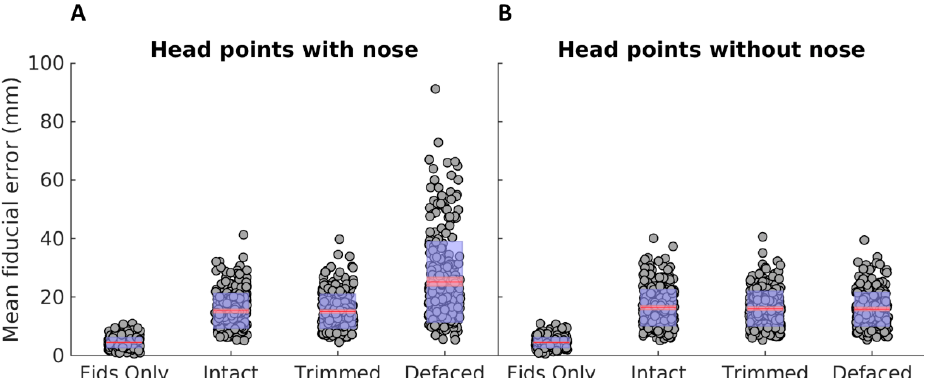
Figure 3. ( A ) Mean difference in position (error) between the fiducials defined in MRI and the fiducials defined in MEG, when both images were coregistered using OSL’s RHINO function. ( B ) Same, but after removing the nose points from the MEG head points. The figure shows the median error (in red, SEM as a red shadowed area) and the standard deviation (blue shadowed area) for the coregistration using only the fiducials (Fids Only) or after coregistering the MEG head points to the “Intact”, “Trimmed” or “De-faced”